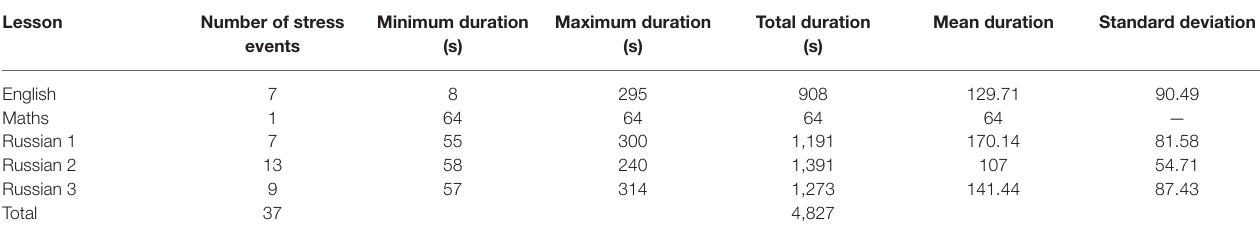
TABLE 2 | Number and stress duration by lesson (total and mean).